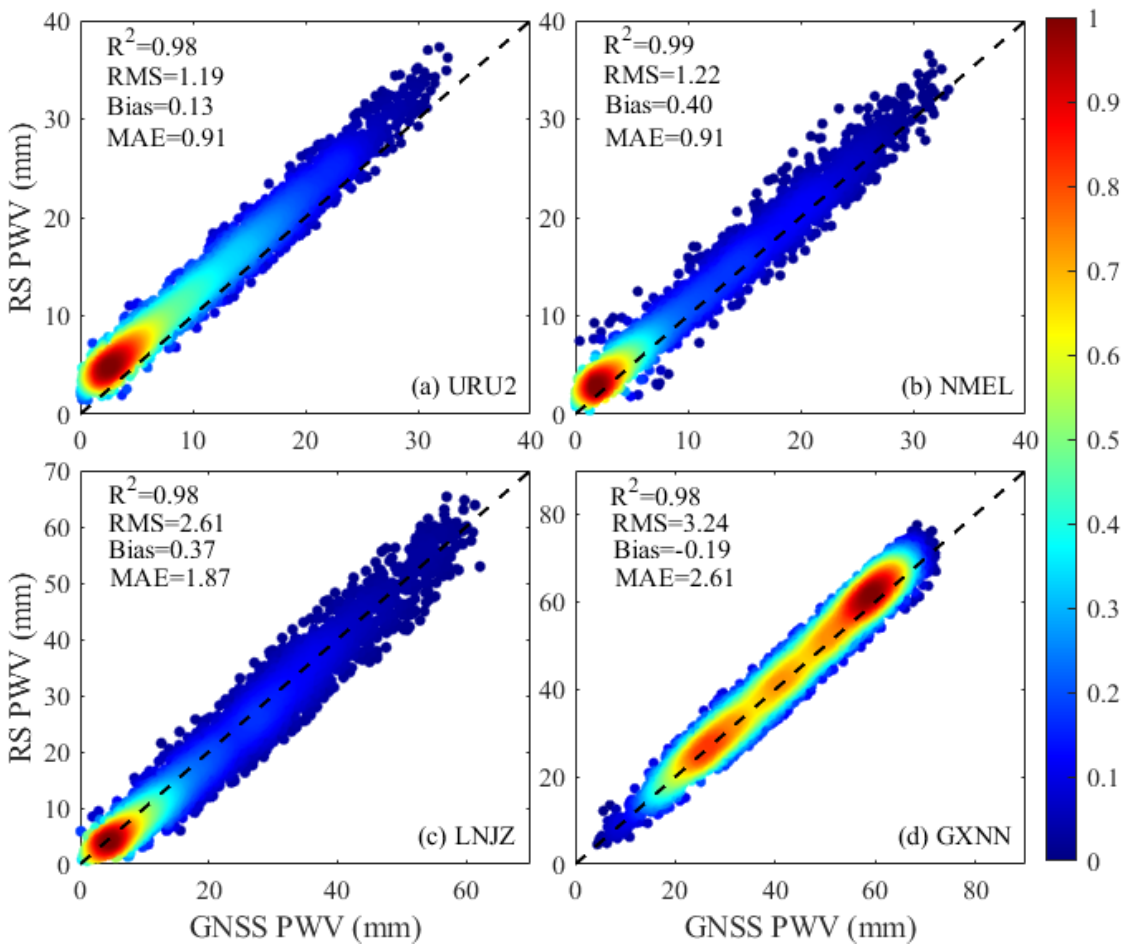
Figure 3. Scatter density diagram of PWV derived from four collocated stations over the period of